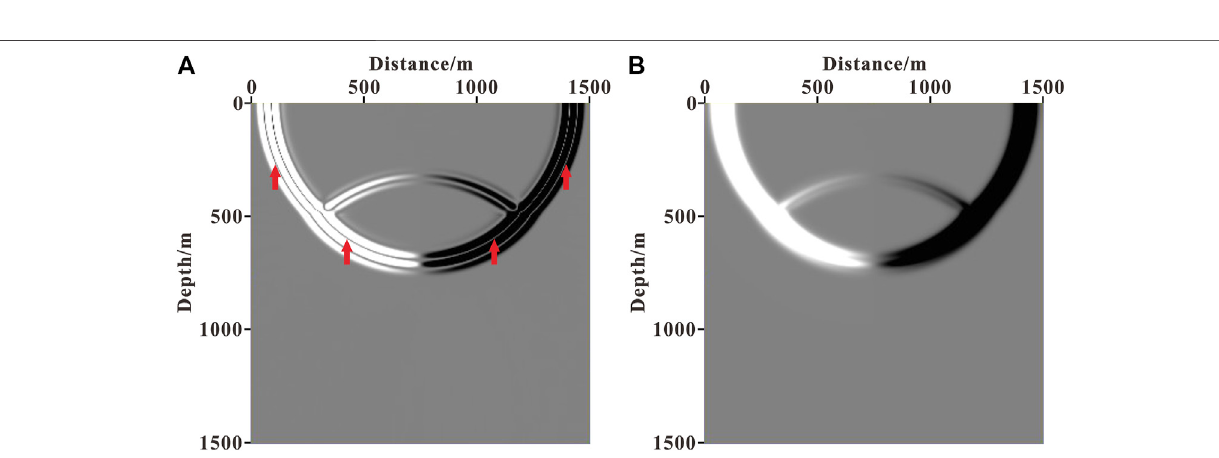
FIGURE 4 | Horizontal components: (A) the Poynting vector; (B) the optical fl ow vector.